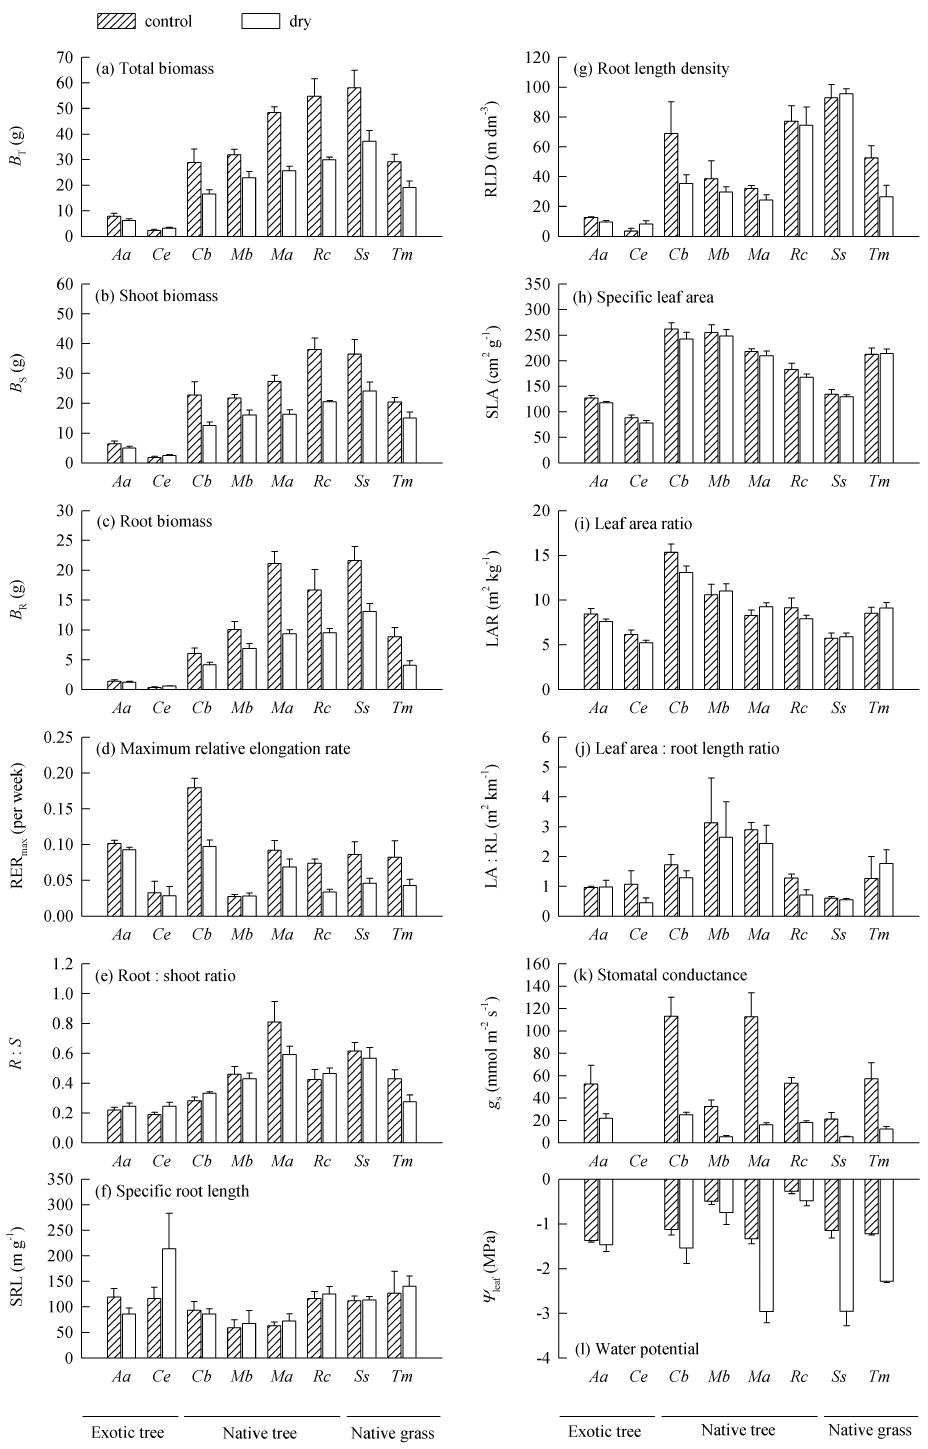
Figure 1. Functional traits related to drought resistance of two exotic tree species ( Aa , Acacia auriculiformis ; Ce , Casuarina equisetifolia ), four native tree species ( Cb , Commersonia bartramia ; Mb , Mallotus barbatus ; Ma , Melia azedarach ; Rc , Rhus chinensis ), and two native grass species ( Ss , Saccharum spontaneum ; Tm , Thysanolaena maxima ) measured in a control and a dry treatment. All values are individual based means ( ±